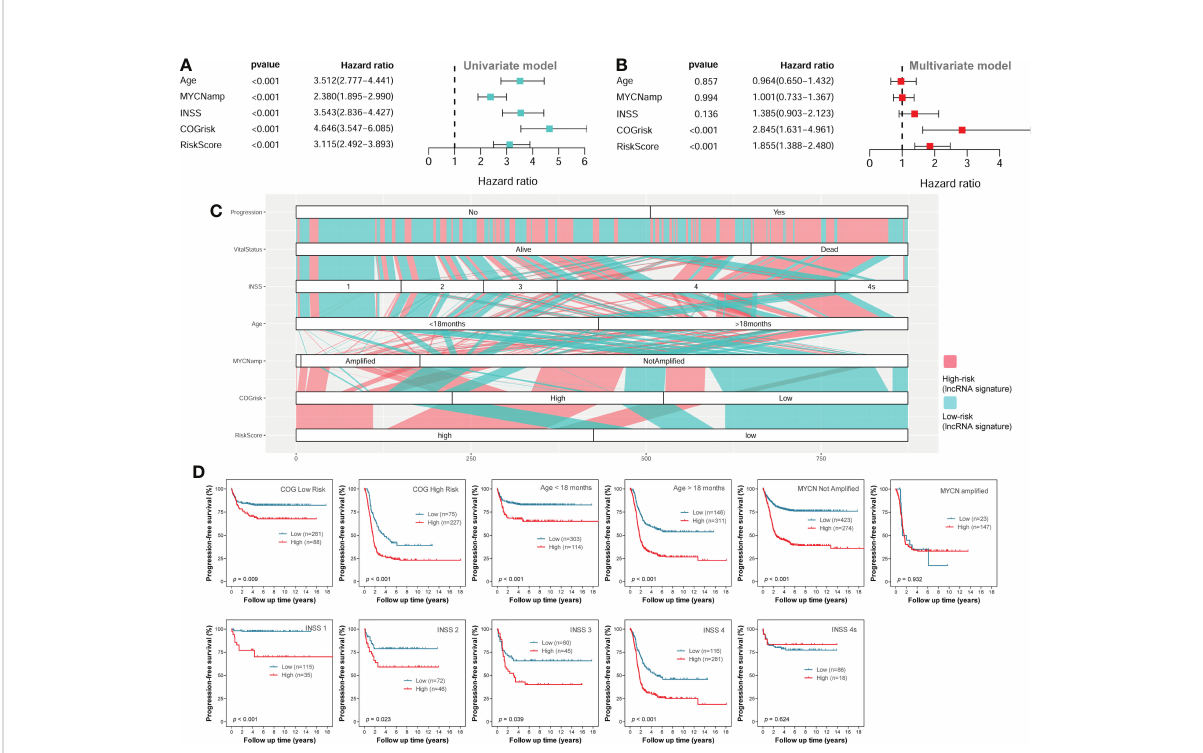
FIGURE 6 Survival analyses in the entire combined cohort. (A) The univariate survival analysis of the lncRNA signature and other clinical risk factors. (B) The multivariate survival analysis of the lncRNA signature and other clinical risk factors. (C) The alluvial diagram shows the relationship of lncRNA signature risk classi fi cation and other clinical risk factors. (D) The Kaplan-Meier plots show the PFS of different lncRNA signature risk classi fi cation (high-risk vs low-risk) in different subgroups of the entire combined cohort; the two-sided log-rank tests p-values were shown. lncRNA, long noncoding RNA; PFS, progression-free